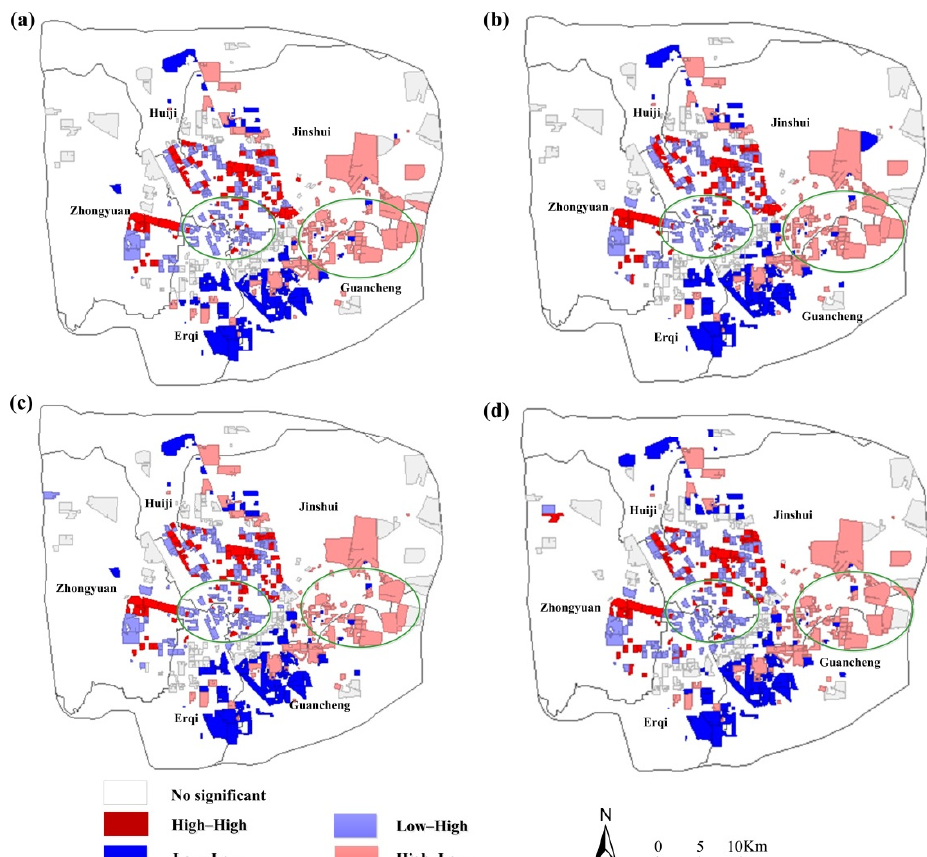
Figure 6. LISA (Local Indicators of Spatial Association) cluster map of the distribution of GVI exposure clusters (The buffer is ( a ) 5 min (360 m), ( b ) 10 min (720 m), ( c ) 15 min (1080 m), and ( d ) 30 min (2160 m) in sequence).